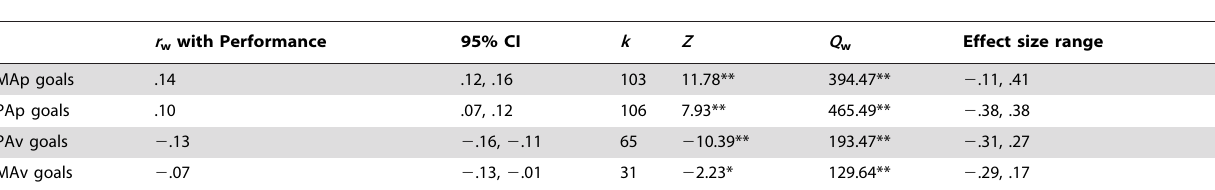
Table 2. Results for the Overall Achievement Goal-Performance